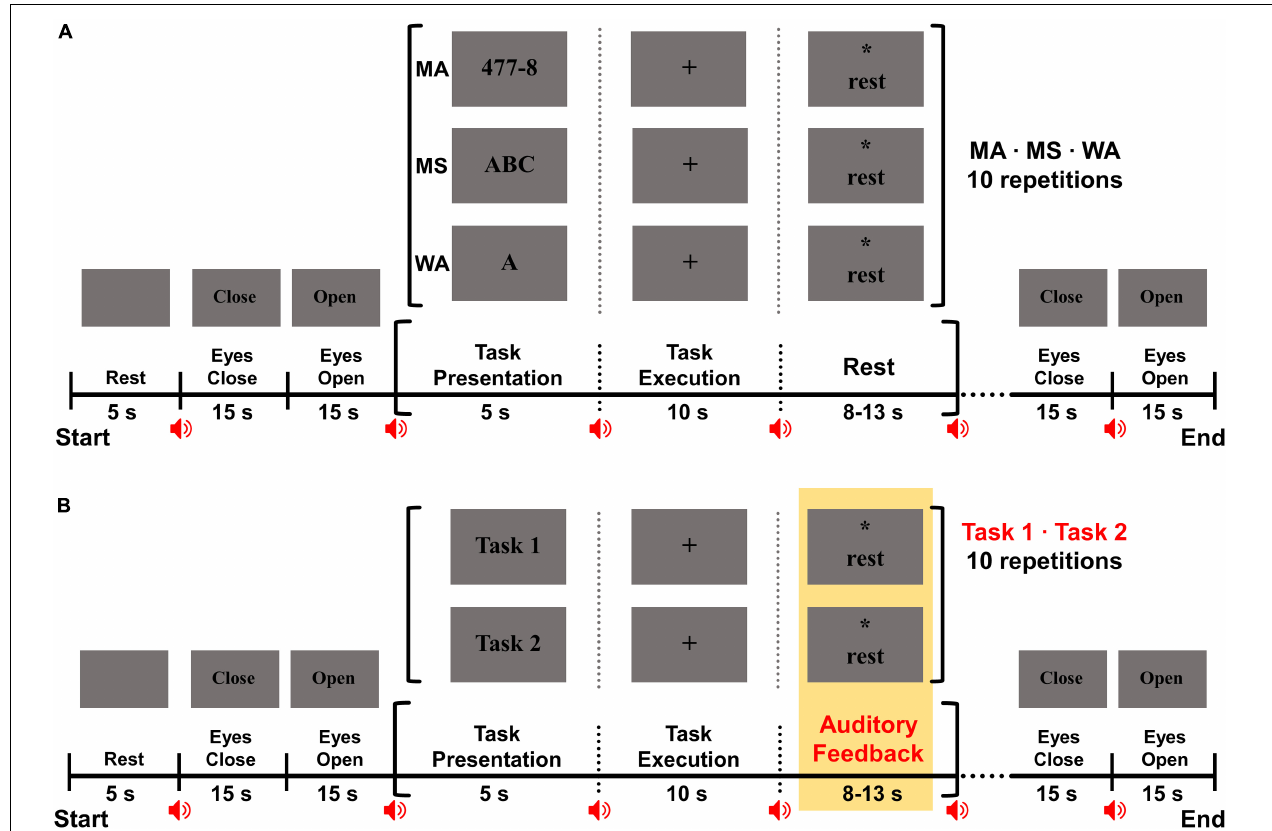
FIGURE 2 | (A) Schematic of the offline experimental paradigm. At the beginning of each session, a 5 s rest period was provided for preparing for the upcoming task. Before and after performing three mental tasks, the eyes were closed and opened for 15 s each to check the reliability of ear-EEG data related to alpha activity changes. A single trial comprised a 5 s task presentation period, a 10 s task execution period, and an 8 to 13 s rest period. During a task presentation period, a mental task that was to be performed was displayed for 5 s (e.g., 477 – 8 for MA, the string “ABC” for MS, and a Korean character for WA). During a task execution period, subjects were instructed to perform an indicated mental task for 10 s while focusing on a black fixation cross displayed at the center of a screen, to minimize eye movements. During a rest period, the word “rest” was presented along with an asterisk on the screen, and the subject was instructed to take a break without any thought and movement while staring at the asterisk. A short beep was presented at every screen transition (red speaker icons) to explicitly indicate the transition. (B) Schematic of the online experimental paradigm. The online experiment paradigm was identical to that of the offline experimental paradigm, except that an individually selected best pair of mental tasks was used for each subject and auditory feedback was provided on the basis of real-time classification results after task